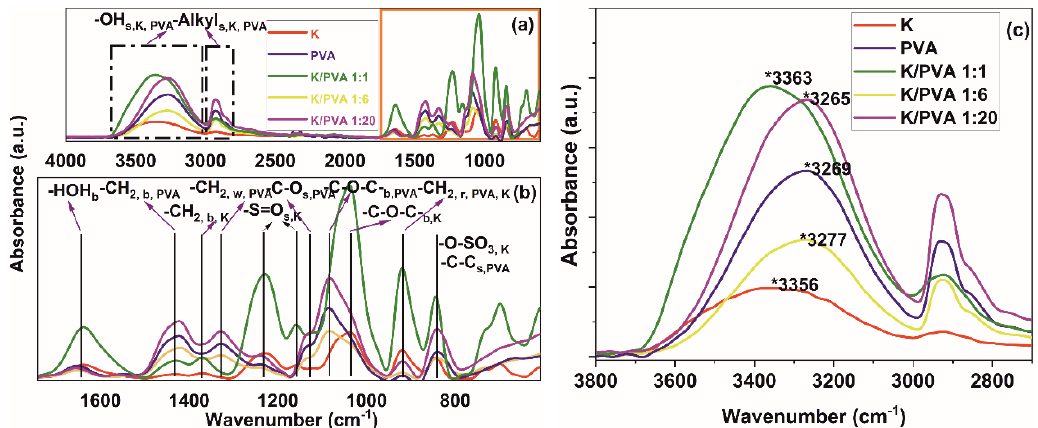
Figure 3. ATR-FTIR spectra of the obtained hydrogels ( a ); detail of the IR fingerprint region ( b ); detail on the 3800–2700 cm −1 region ( c ); spectra detail for -OH and alkyl groups region (s: stretching; b: bending; w: wagging; r: rocking